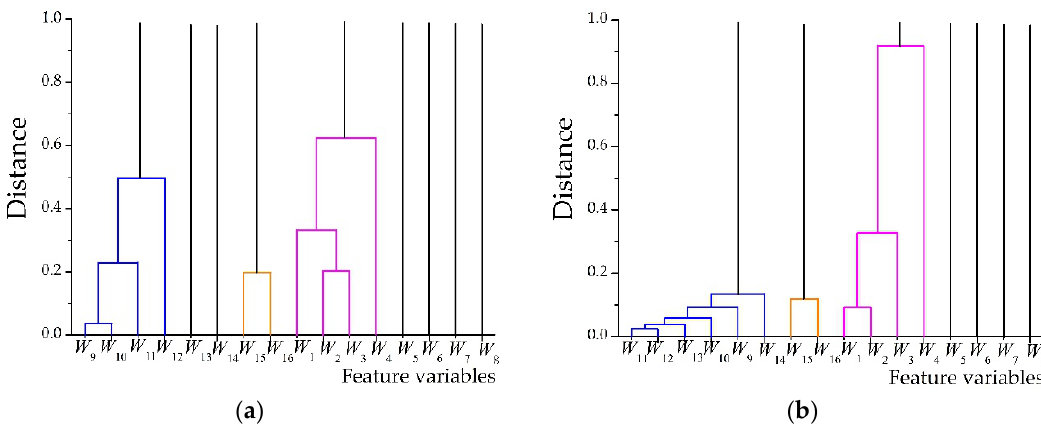
Figure 5. Hierarchical clustering results of feature vectors of AAV3: ( a ) Result of acoustic feature vector; ( b ) result of seismic feature vector.